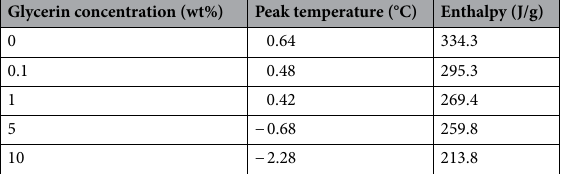
Glycerin concentration